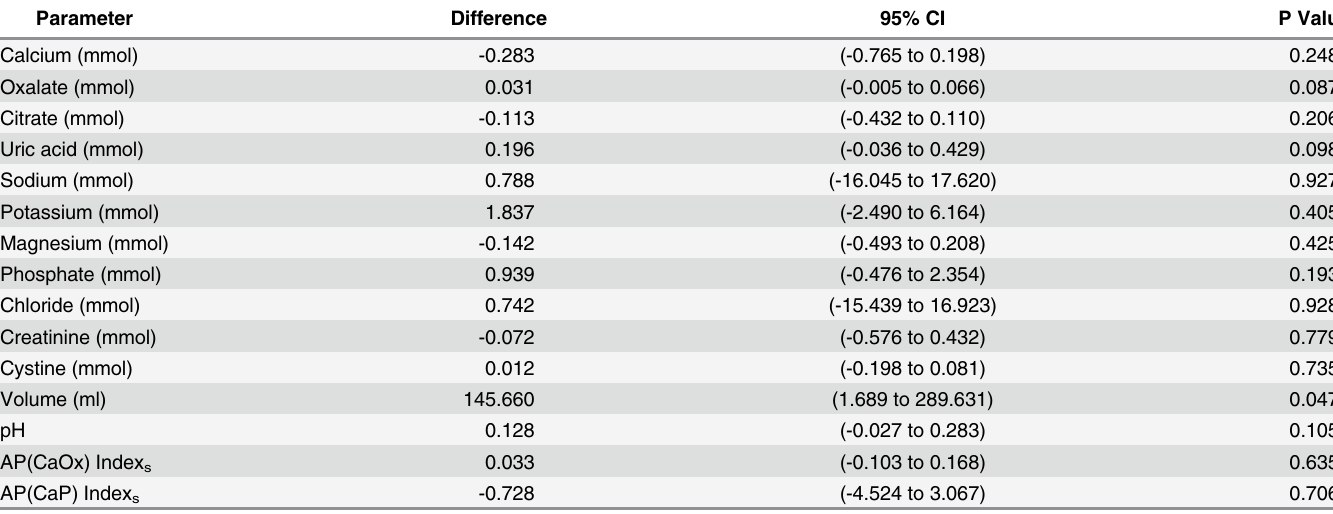
Table 3. Multivariate adjusted differences in 24-h urinary excretion between diabetic and non-diabetic adults.